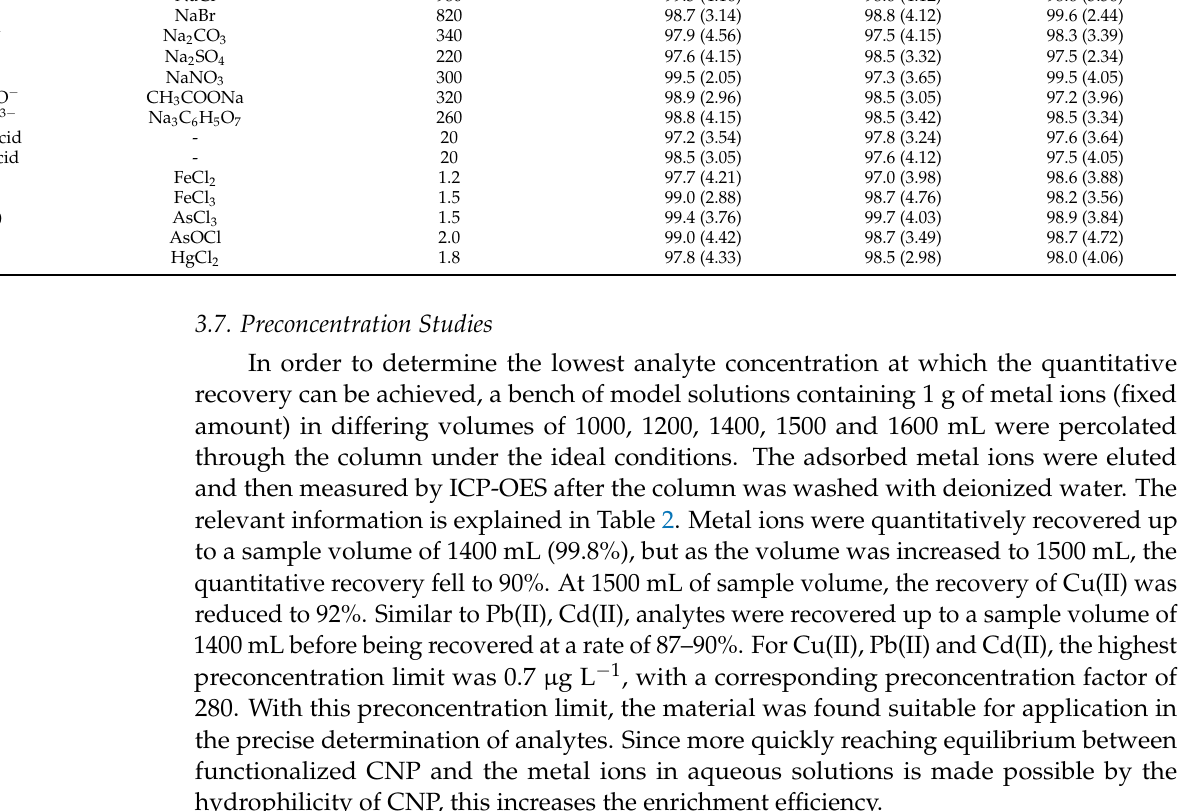
Table 2. Preconcentration studies data for CNP/EDTAPEI (column parameters: M n+ = 1.0 µ g, pH